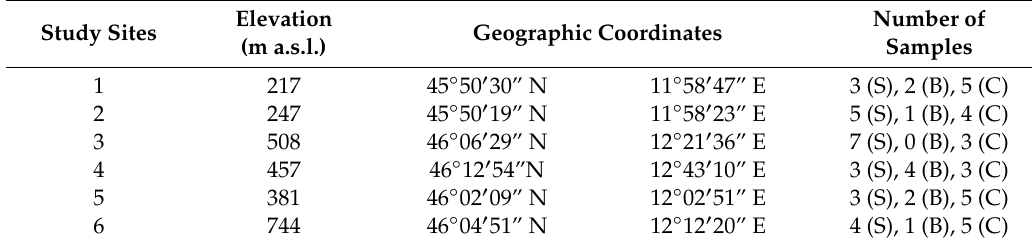
Table 1. Study sites information and number of symptomatic shoots (S), branches with brown inner bark discolorations (B) and branches with sunken cankers (C) used for fungal isolation. Elevation Geographic Coordinates Study Sites (m a.s.l.)